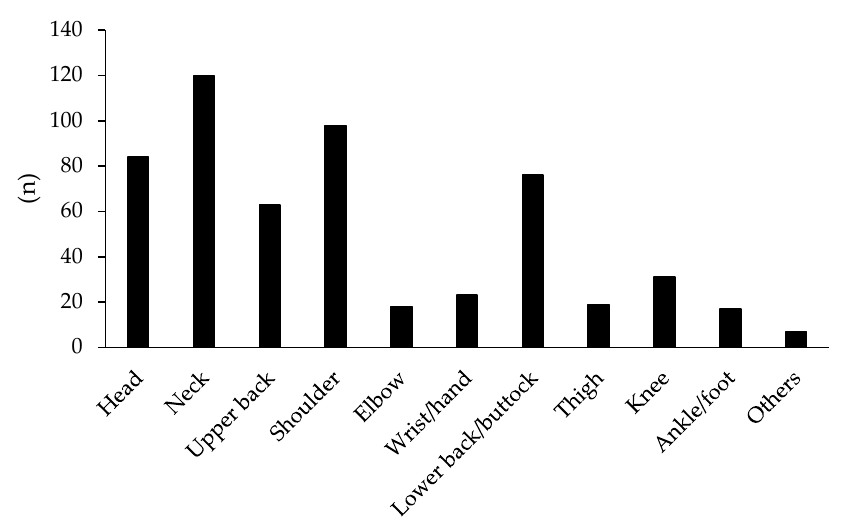
Figure 2. Body parts where pain was augmented during the declared state of emergency or while refraining from going outside during the COVID-19 pandemic.